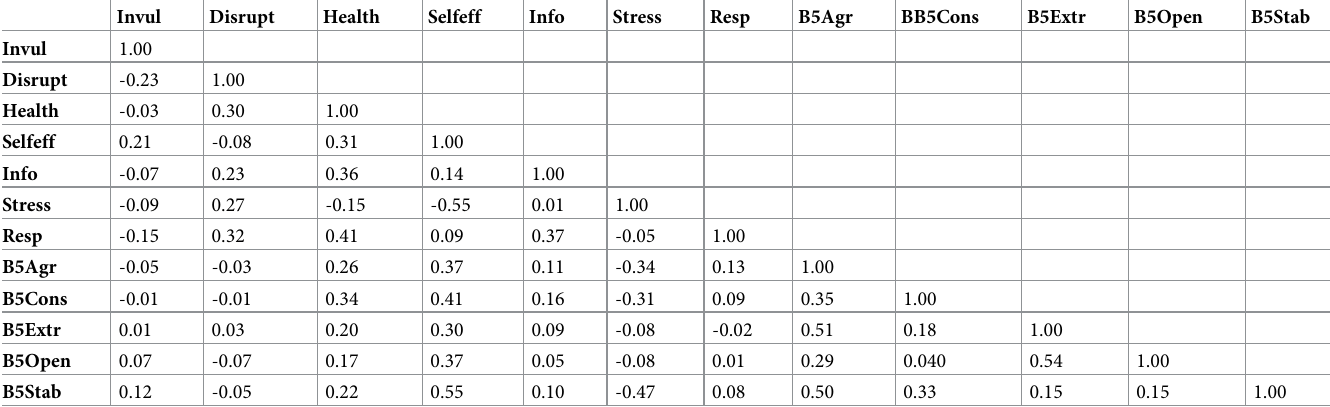
Table 2. Pearson